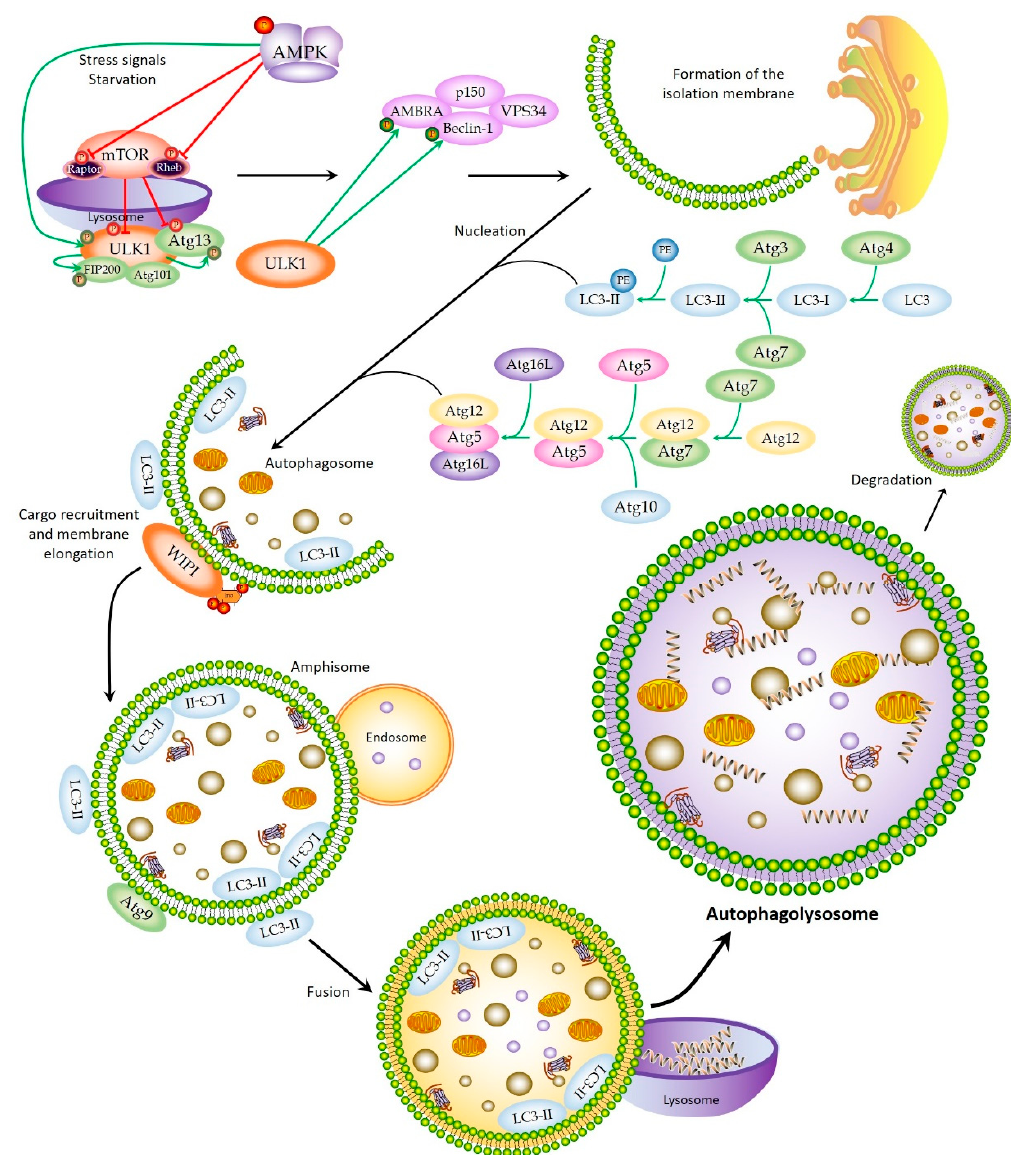
Figure 1. Autophagy pathway. Schematic representation of the autophagy pathway. This complex mechanism is activated by stress signals or starvation and proceeds through a series of steps, including formation of the isolation membrane; membrane nucleation, elongation, and completion of the autophagosome; autophagosome maturation by fusion with a lysosome; and, finally, degradation of autophagic cargoes and recycling of the resulting molecules.